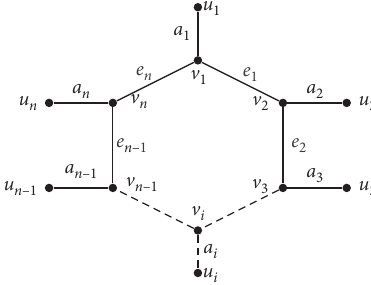
Figure 19: The crown graph R